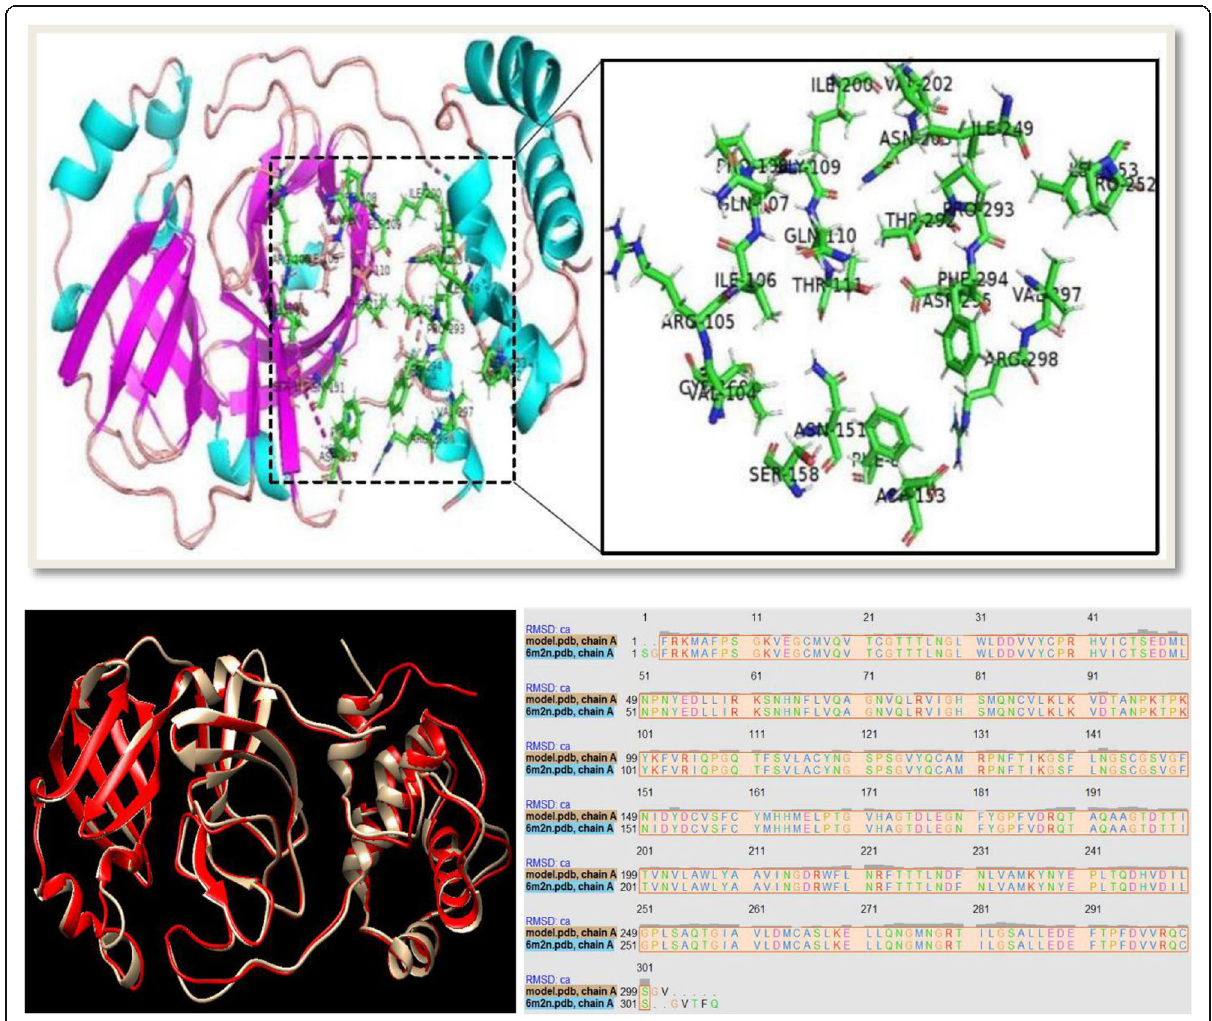
Fig. 13 Amino acid residues forming the target protein active